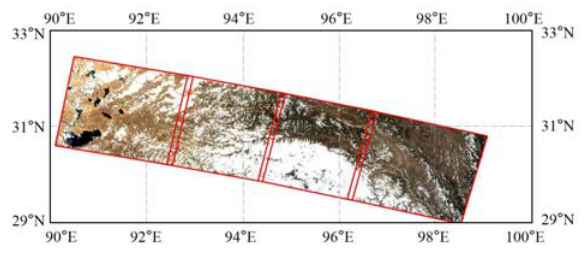
Figure 1. Four SC images that the WFV imaging system observed at the same